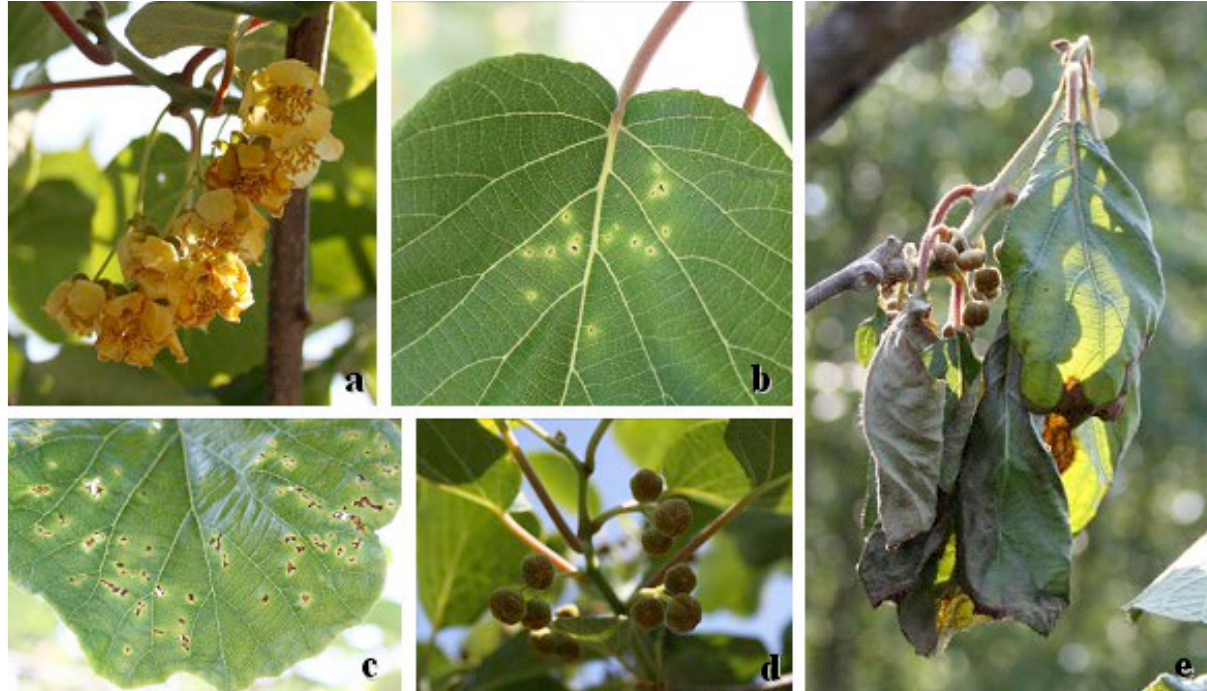
Figure 1. Natural symptoms caused by Pseudomonas syringae pv. actinidiae on flowers of Actinidia chinensis cv. Soreli (a) and leaf of cv. Belen (b), and on a leaf of A. deliciosa cv. Hayward (c), buds of cv. Bo Erica (d) and a twig of cv. Summer